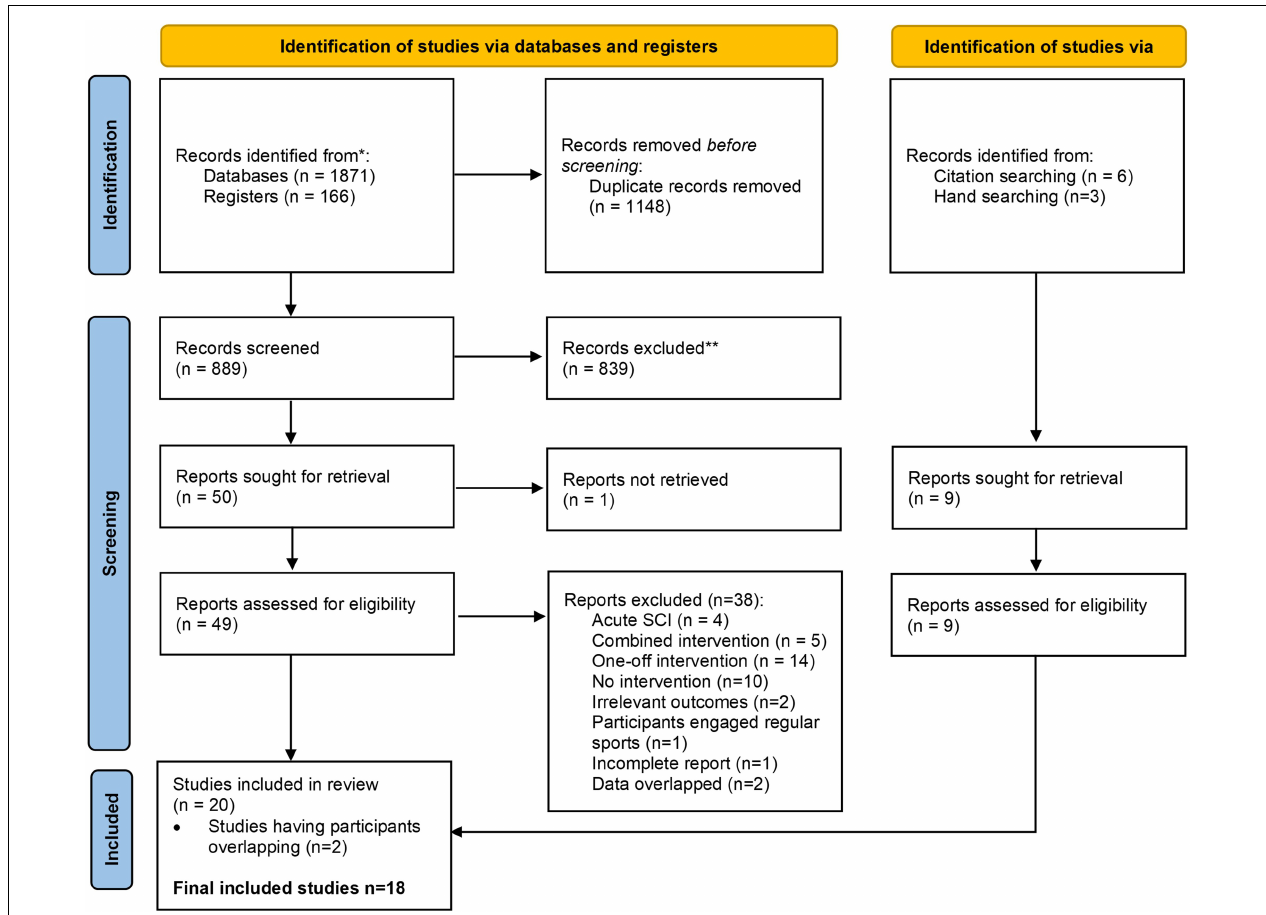
FIGURE 1 | PRISMA flow